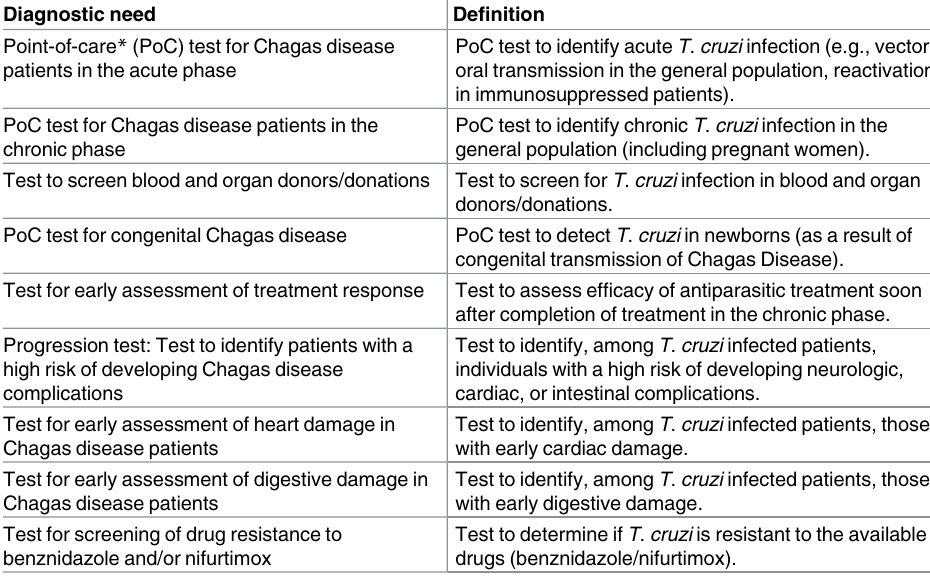
Table 1. Diagnostic needs for Chagas